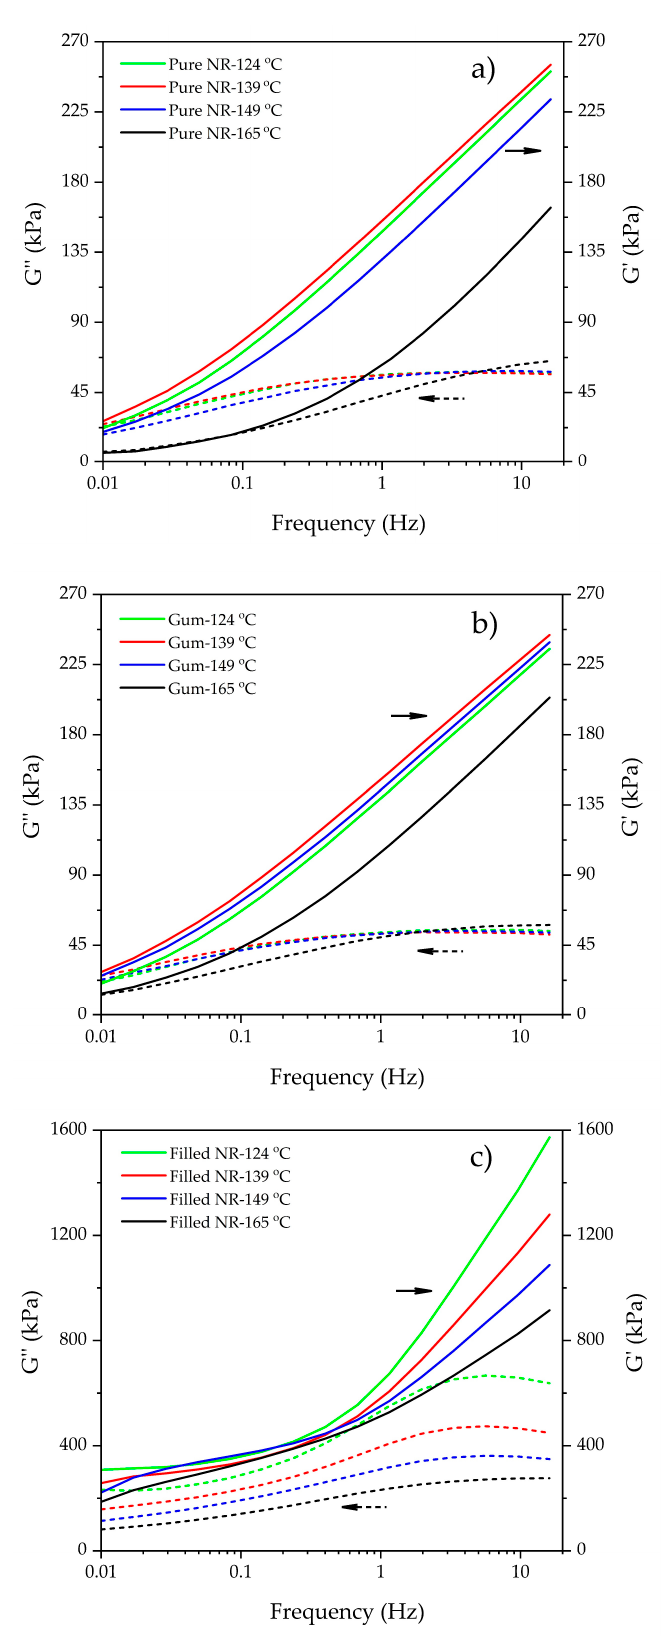
Figure 4. Storage and loss moduli as function of frequency for the masticated pure NR ( a ), gum ( b ), and filled NR ( c ) subjected to different dump